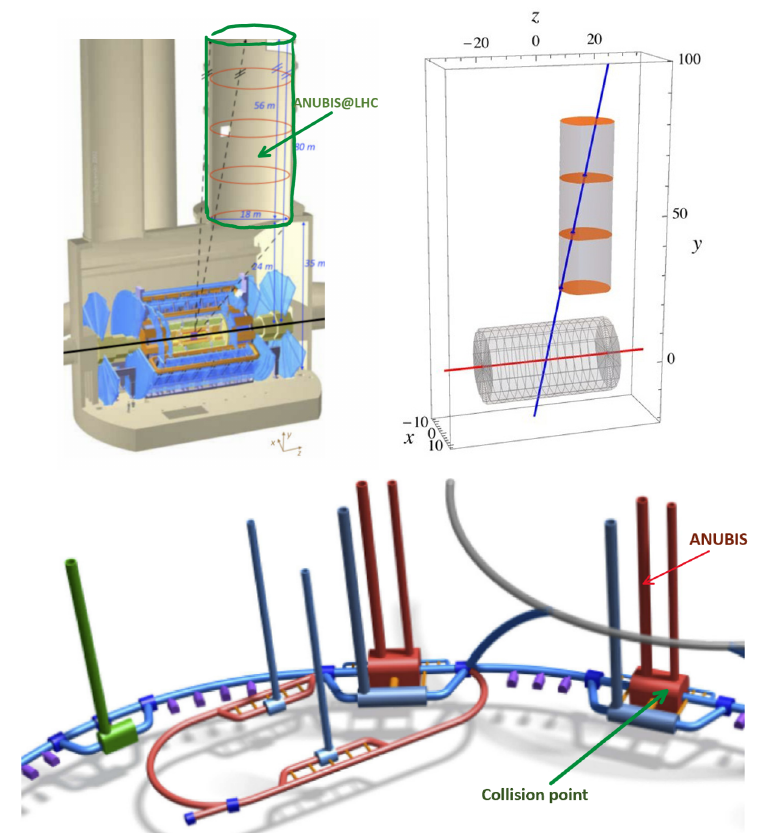
Figure 5 . Top: detector location and geometry of ANUBIS at LHC in the PX14 shaft near the ATLAS experiment [29]. Four circular detectors of 9 m radius are separated by about 18.5 m distance in the vertical direction. Bottom: possible detector location in the shaft of FCC.